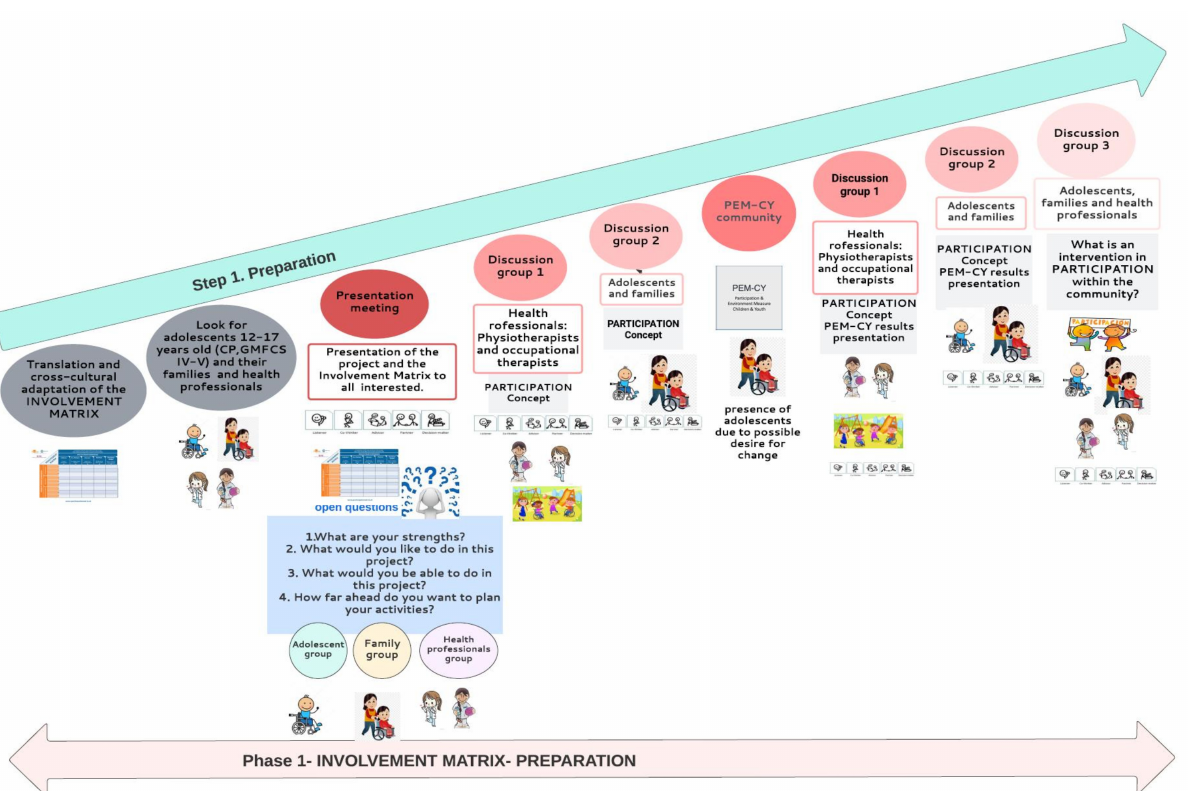
Figure 4. Step 1 of project’s research in phase 1 of the Involvement Matrix: